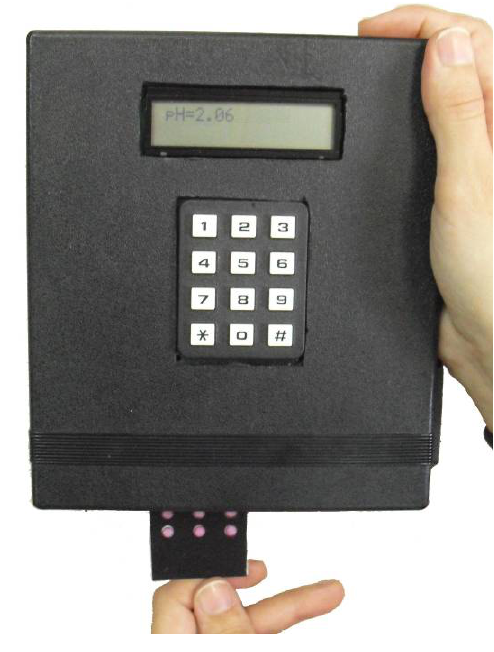
Figure 2 . Photograph of the